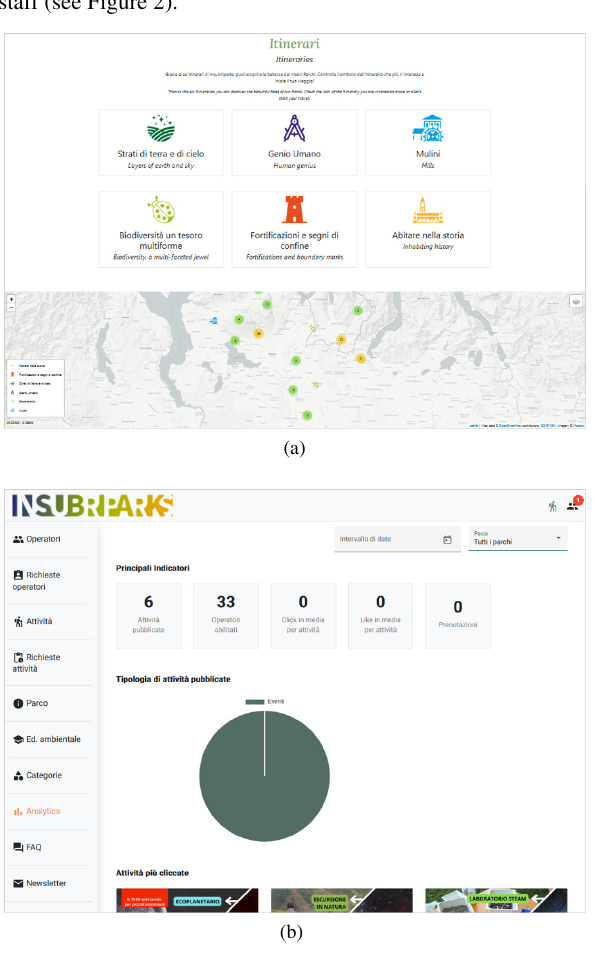
Figure 2. Sample map content of the INSUBRIPARKS Web portal (https://insubriparksturismo.eu/itinerari) (a) and a preview of the analytic Web dashboard interface